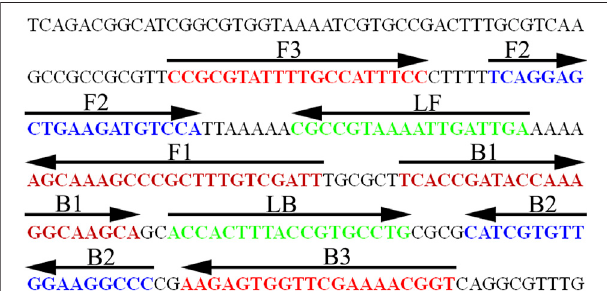
FIGURE 2 | Nucleotide sequence and location of the orf1 gene used to designthe N.gonorrhoeae -LAMPprimers.Thepartofnucleotidesequenceof the sense strand of the orf1 gene is shown in the diagram. The primer sequences are marked in different colors. Right arrows and left arrows indicate sense and complementary sequences, respectively.